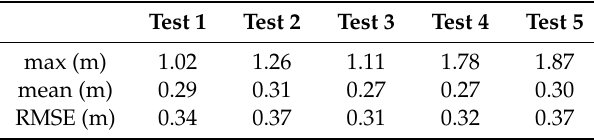
Table 6. 2D positioning